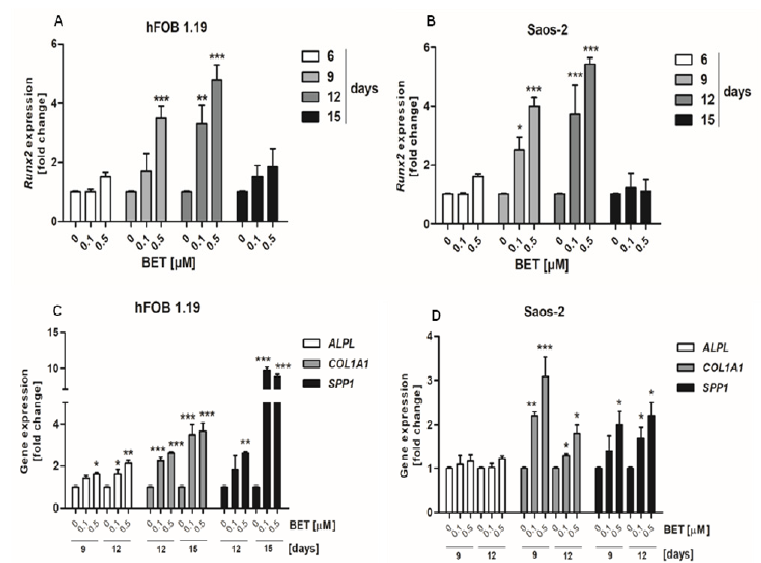
Figure 2. Effect of BET on the expression of RUNX2 and other differentiation marker genes in osteoblasts in osteogenic conditions. The osteoblasts were cultured in an osteogenic medium supplemented with 0.1 or 0.5 μ M of BET or without the compound (control). The expression of the RUNX2 gene was determined in the hFOB 1.19 ( A ) and Saos-2 ( B ) cells by RT-qPCR after the indicated period of culture. The expression of osteogenic genes ALPL , COLIA1 (type I collagen), and SPP1 (OPN) was determined in the hFOB 1.19 ( C ) and Saos-2 ( D ) cells by RT-qPCR after the indicated period of culture. Mean ± SD from three independent experiments; * p < 0.05, ** p < 0.01, *** p < 0.001 in comparison to the control, one-way ANOVA with post hoc Dunnett’s test.